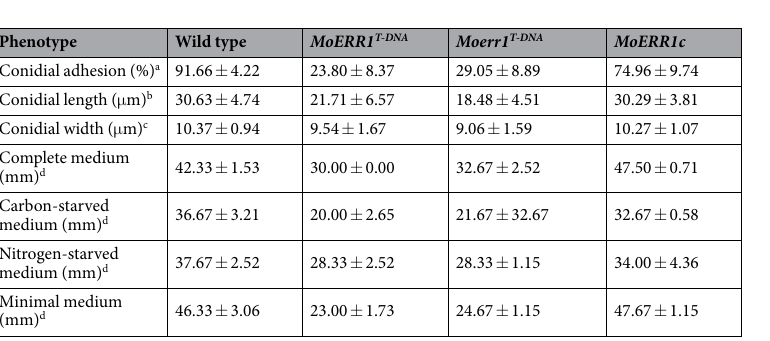
Table 1. Characterization of developmental characteristics in M . oryzae wild-type, MoERR1 T-DNA , Moerr1 T-DNA and MoERR1c strains. a Percentage of conidia attached to hydrophobic surfaces at 2 hpi. Attached conidia were counted under a light microscope. Data are presented as the mean ± SD from three independent experiments of over 100 conidia each. b Average conidia length ( μ m). Data are presented as the mean ± SD from three independent experiments of over 100 conidia each. c Average conidia width ( μ m). Data are presented as the mean ± SD from three independent experiments of over 100 conidia each. d Hyphal growth (mm) was measured at 9 dpi. Data are presented as mean ± SD of three independent